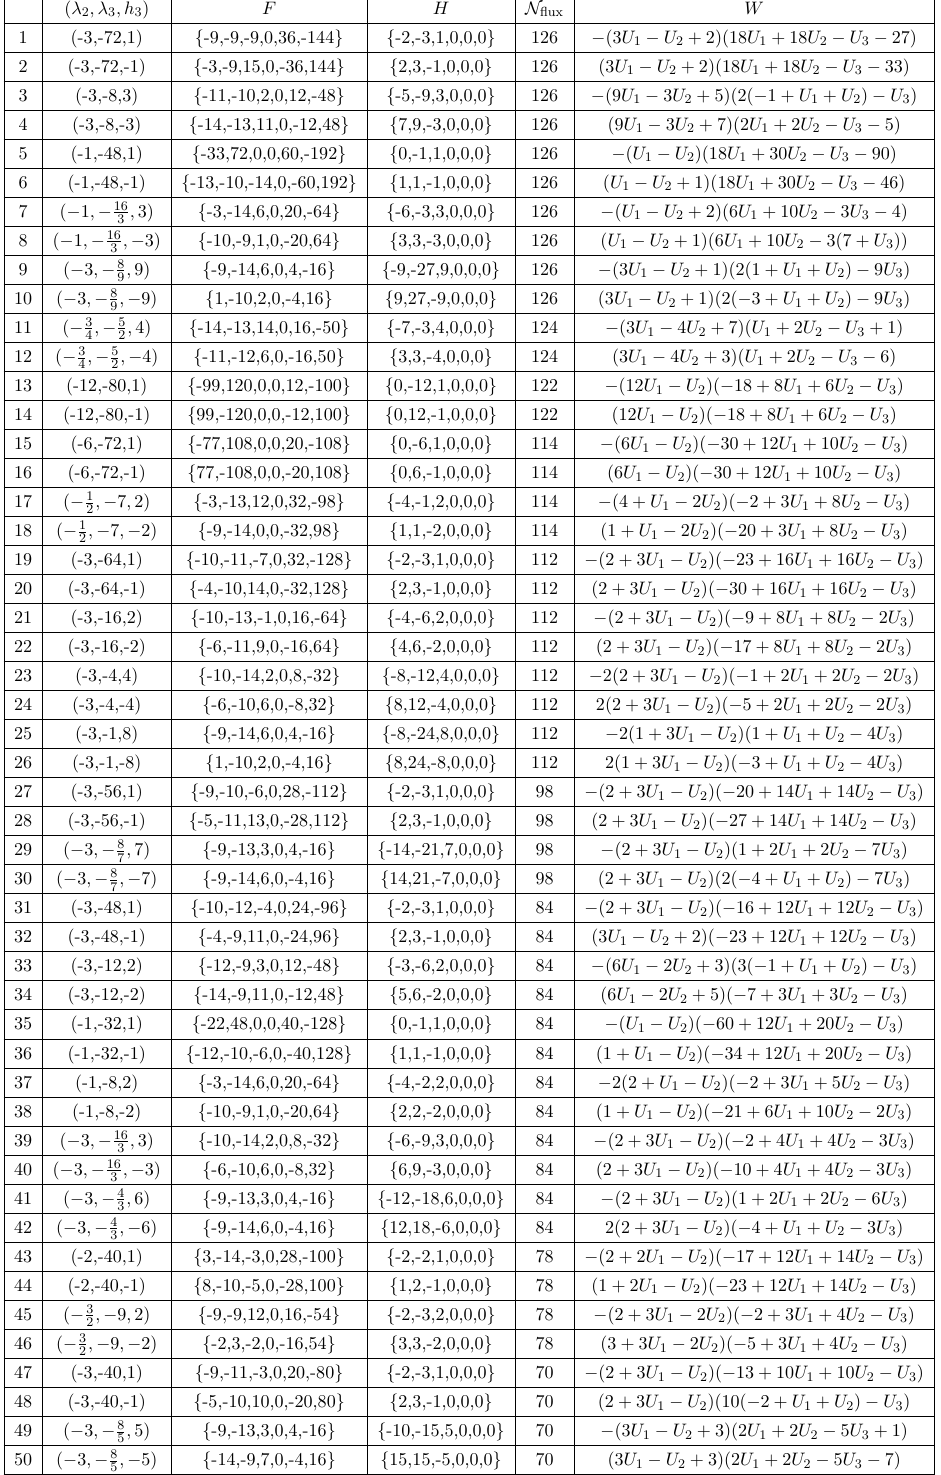
Table 1 . Representatives of families of integer fluxes for solutions with W = 0 and 1 flat direction, Part 1